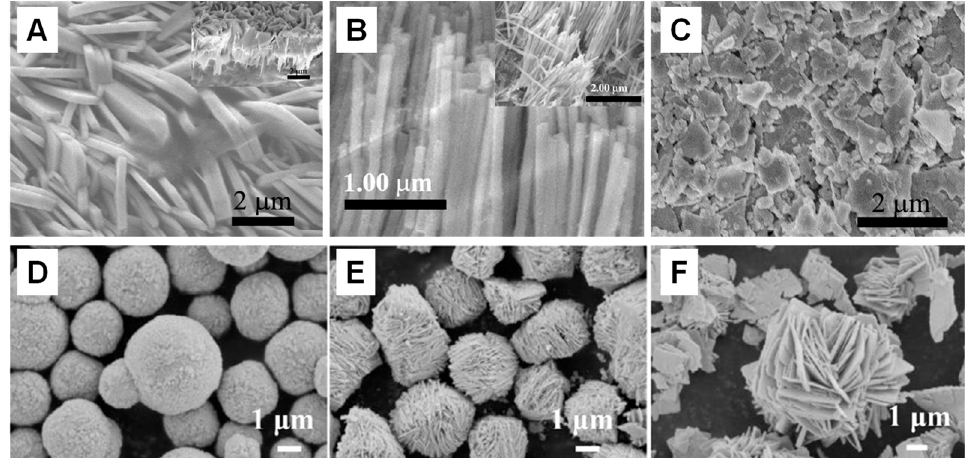
Figure 3. ( A – C ) SEM images of BiOCl flake ( A ) and nanowire arrays ( B ) on AAO template ( A ), flake- like film on glass template ( C ); reproduced with permission from Refs. [ 45], 2010 and 2011, Elsevier; ( D , E ) SEM images of BiOCl nanoneedle- and nanosheet-assembled microspheres. Reproduced with permission from Ref. [ 46], 2020, Elsevier.